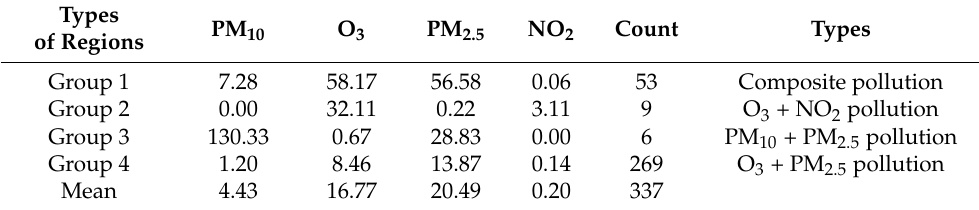
Table 3. Types of regions of the major pollutants during the CAP periods.